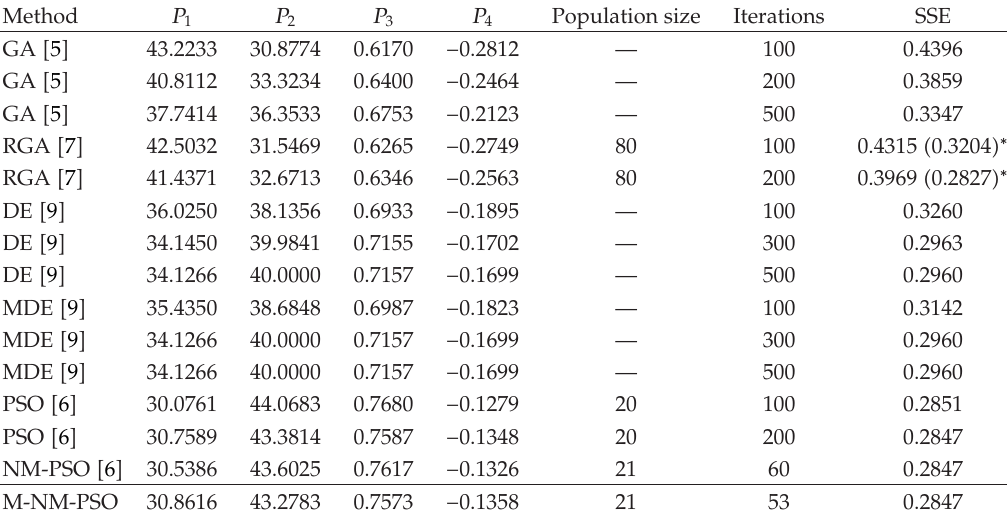
Table 4: Results of Case 2 (cid:3) A second-order system (cid:4)